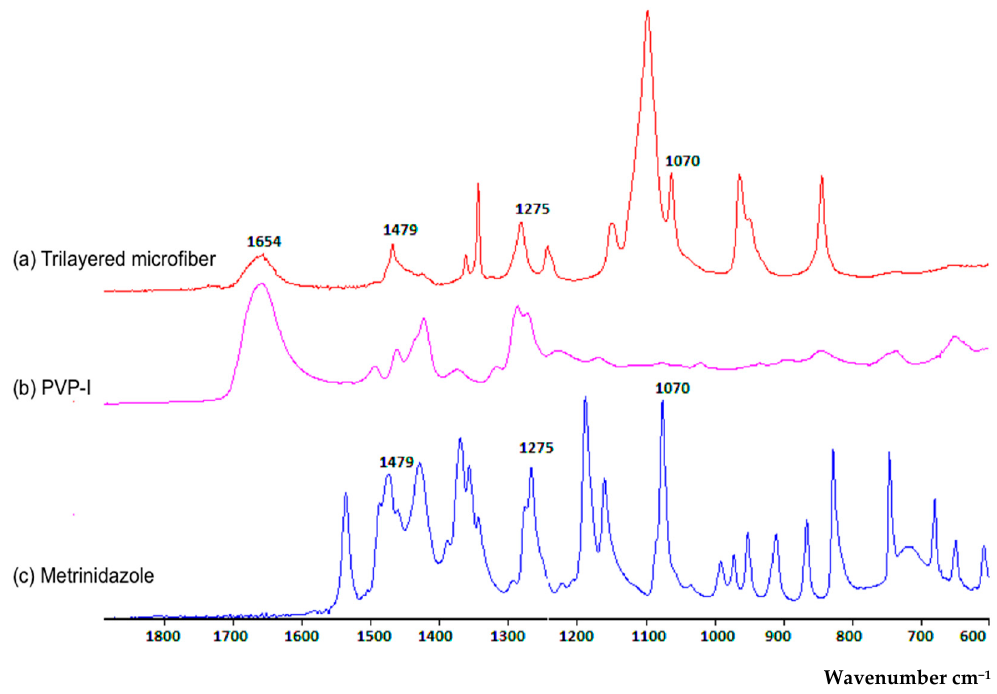
Figure 4. FTIRspectraofthe( a )trilayeredfiber; ( b , c )theactivecomponents: ( b )PVP-Iand( c )metronidazole. Pharmaceutics 2020 , 12 , x FOR PEER REVIEW Figure 4. FTIR spectra of the ( a ) trilayered fiber; ( b , c ) the active components: ( b ) PVP-I and ( c ) metronidazole.